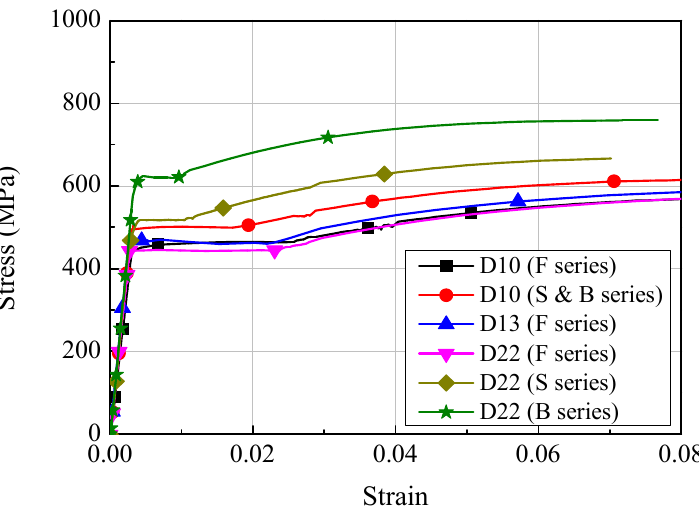
Figure 2. Stress-strain relationships of concrete. Figure 2. Stress ‐ strain relationships of concrete.